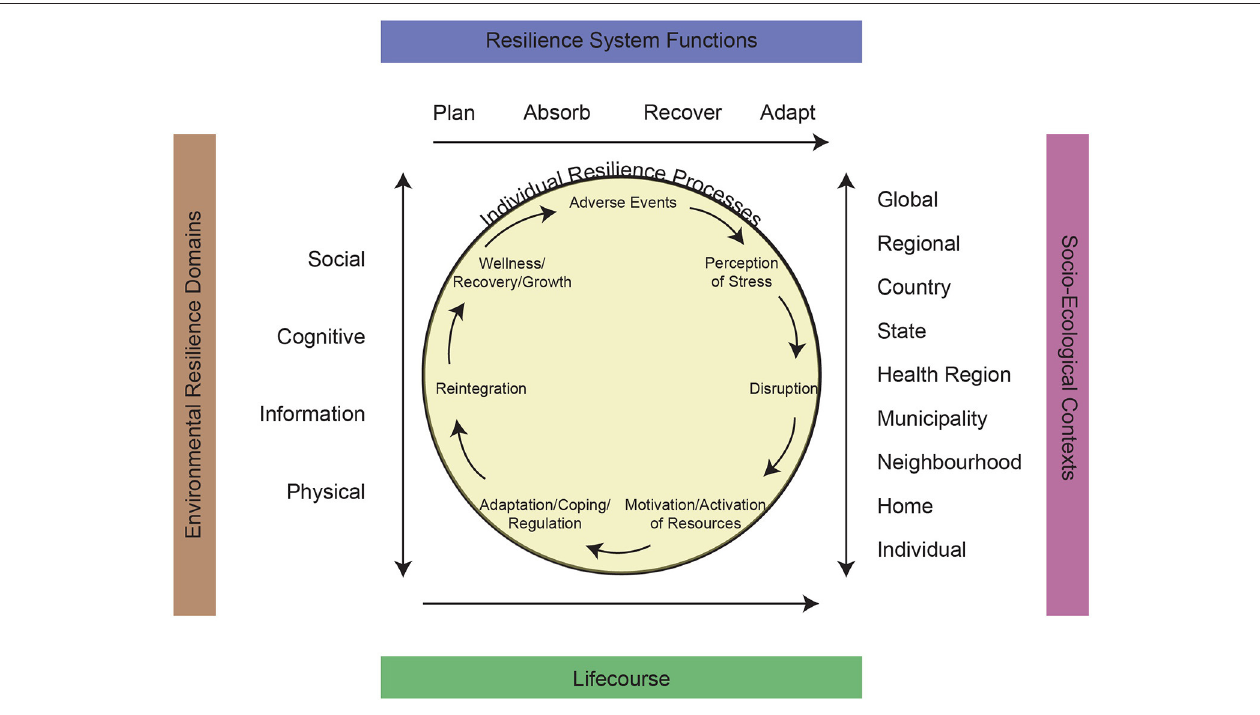
FIGURE 1 | A unified model of resilience and